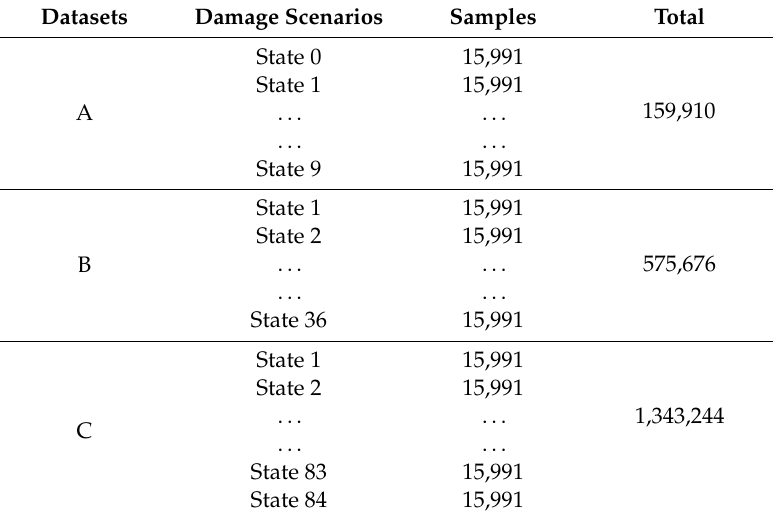
Table 2. Samples of dataset